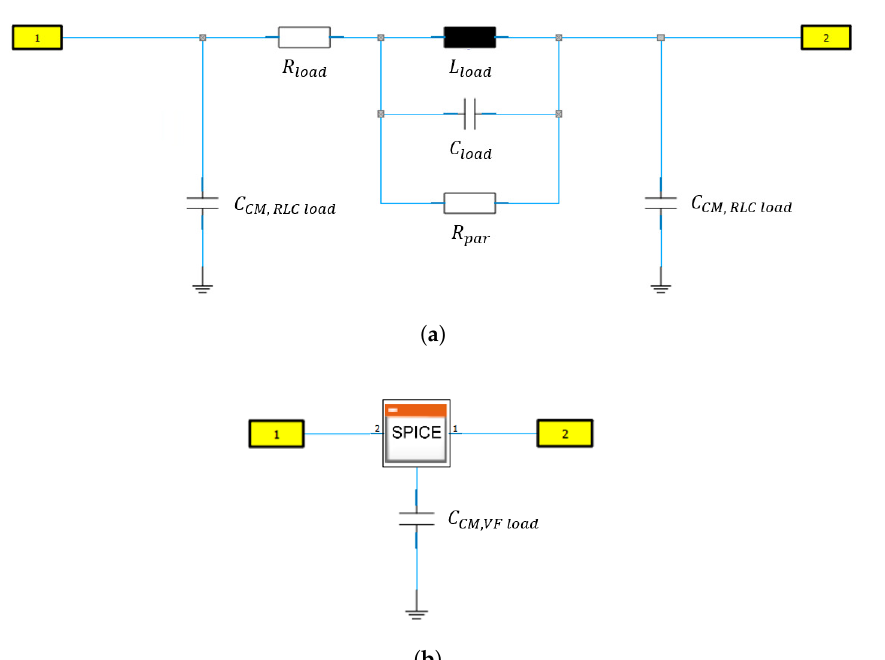
Figure 22. Equivalent circuit model of the connected load. ( a ) Simple RLC circuit model describing only the first parallel resonance and the CM capacitance towards the metal table. ( b ) Equivalent circuit model generated from the DM measurement utilizing vector fitting. The parameter values are comprised in Table 6.